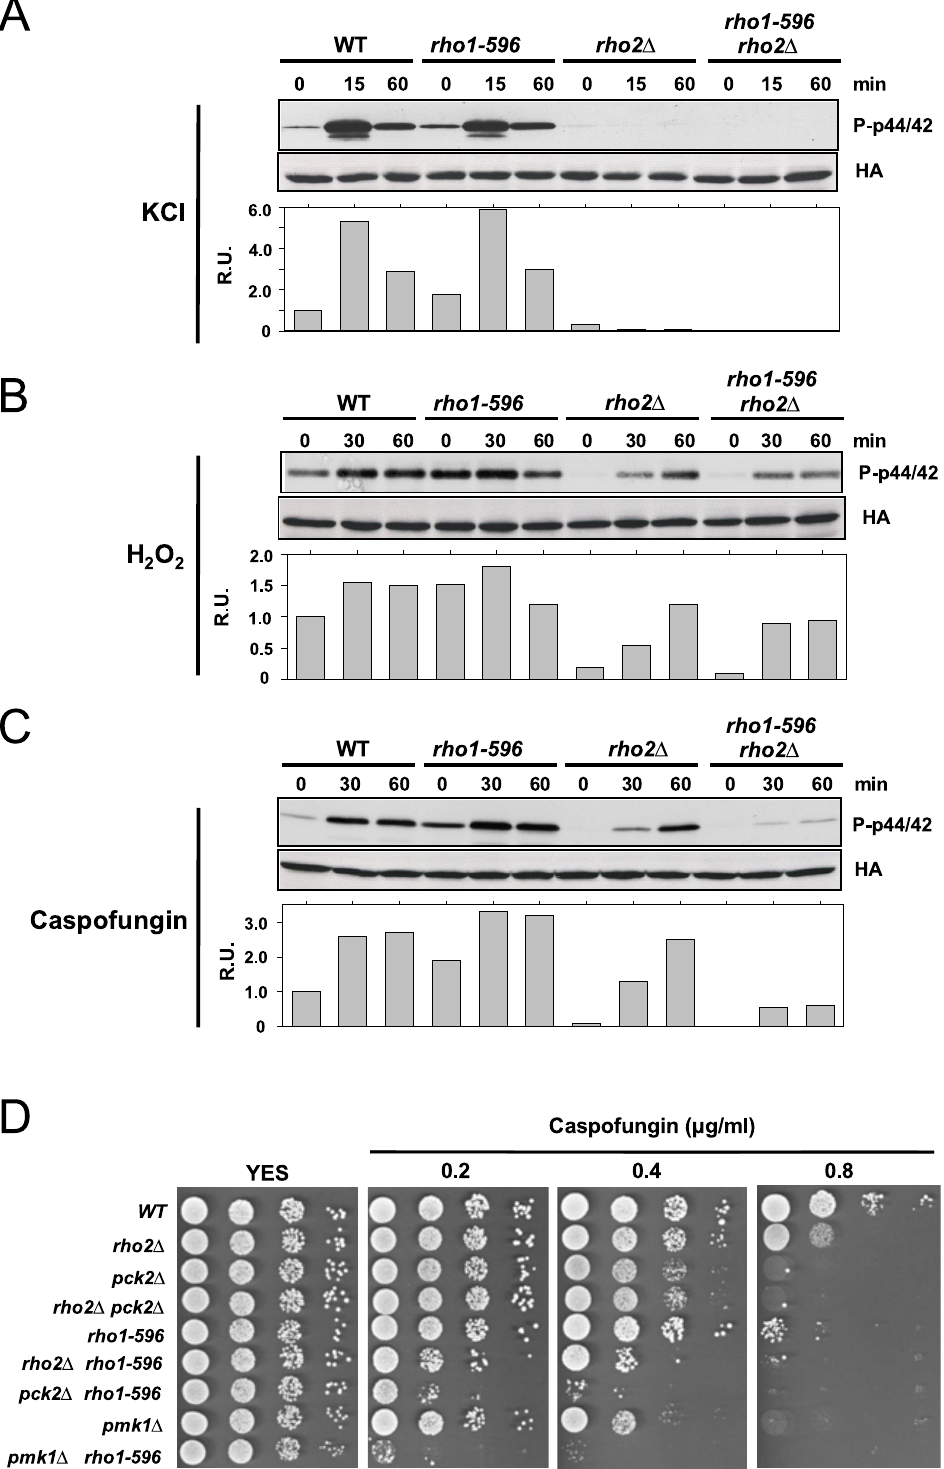
Figure 2. Rho1 is involved in Pmk1 activation in response to cell wall stress. Strains MI200 ( pmk1-HA6H , WT), LS201 ( rho1-596 ), MI700 ( rho2 D ), and LS202 ( rho1-596 rho2 D ) were grown in YES medium to mid log-phase, and treated with (A) 0.6 M KCl, (B) 1 mM H 2 O 2 , or (C) 1 m g/ml Caspofungin. At different times Pmk1-HA6H was purified and both activated and total Pmk1 were detected by immunoblotting with anti-phospho- p42/44 and anti-HA antibodies, respectively. (D) Rho1 and Pmk1 play additive roles in cell survival during cell wall stress. Strains MI200 (WT), MI700 ( rho2 D ), GB3 ( pck2 D ), GB29 ( rho2 D pck2 D ), LS201 ( rho1-596 ), LS202 ( rho1-596 rho2 D ), LS203 ( rho1-596 pck2 D ), MI102 ( pmk1 D ) and LS209 ( rho1-596 pmk1 D ) were grown in YES medium, and 10 4 , 10 3 , 10 2 and 10 cells were spotted onto YES plates supplemented with increased concentrations of Caspofungin. The plates were incubated for 4 days at 28 u C before being photographed. doi:10.1371/journal.pone.0088020.g002 PLOS ONE |